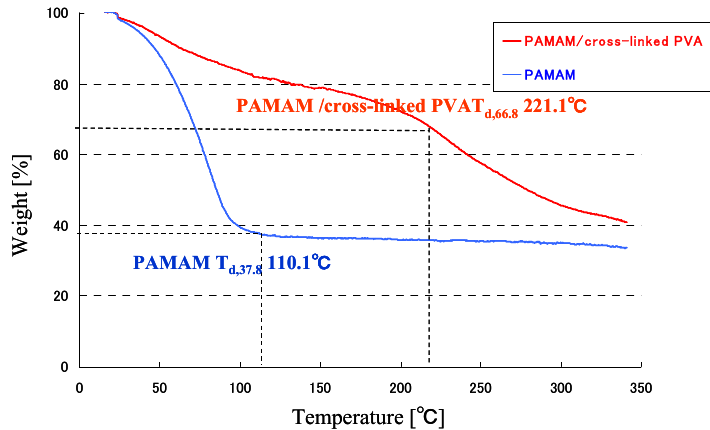
Figure 4. Thermogravimetric analysis (TGA) evaluation of the hybrid membrane and PAMAM dendrimer. TGA curves of ( a ) the PAMAM dendrimer; and ( b ) the PAMAM/cross-linked PVA hybrid